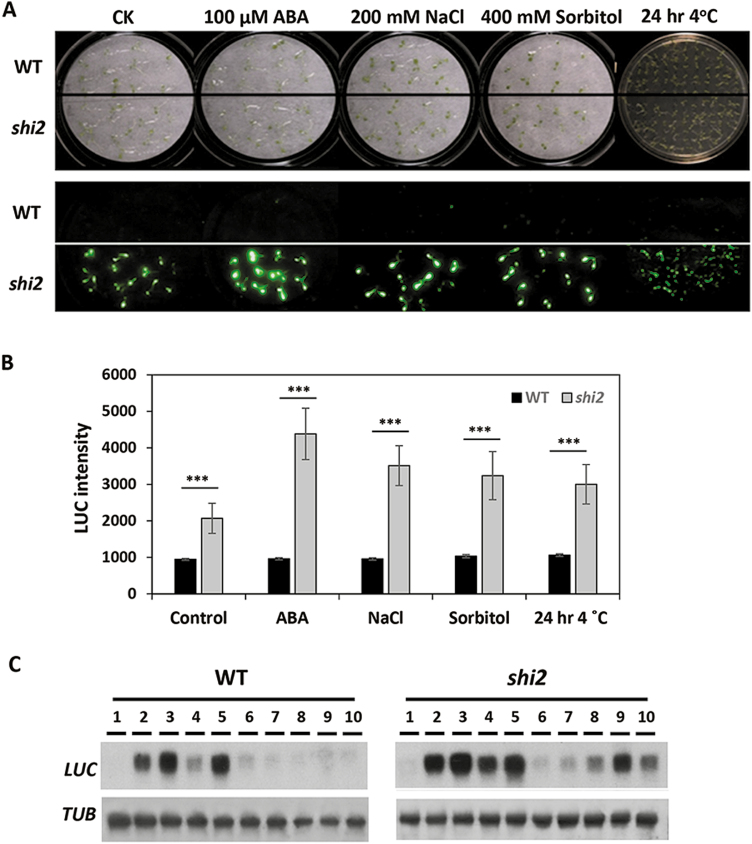
The shi2 mutant shows higher expression of the LUC gene. (A) Bioluminescence images of the wild type and shi2 mutant under different stress conditions. Seven-day-old seedlings grown on 1/2 MS medium were subjected to different stress conditions: 100 µM ABA for 3 h, 200 mM NaCl for 5 h, 400 mM sorbitol for 5 h, and 4 °C cold for 24 h. The upper panel shows bright field images and the lower panel shows bioluminescence images. (B) Quantitative analysis of bioluminescence intensities in wild-type and shi2 seedlings with or without stress treatments. Asterisks indicate a statistically significant difference (n=15, ***P<0.001 by Student’s t-test). (C) Northern blot showing the transcript levels of LUC genes in wild-type and shi2 seedlings in response to different stress conditions: 1, control; 2, 4 °C for 6 h; 3, 4 °C for 12 h; 4, 100 μM ABA for 30 min; 5, 100 μM ABA for 3 h; 6, 100 mM NaCl for 6 h; 7, 100 mM NaCl for 12 h; 8, 200 mM NaCl for 6 h; 9, 200 mM NaCl for 12 h; 10, 400 mM sorbitol for 5 h. (This figure is available in color at JXB online.)